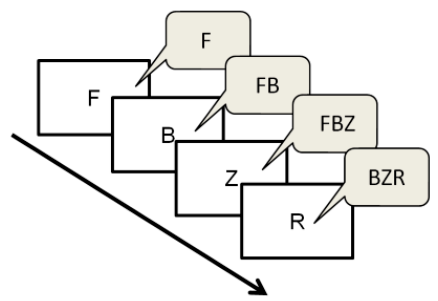
Figure 1. Visual representation of the letter-memory test. Each trial consists of a series of five, seven or nine consonants, one letter at a time, as depicted in the white rectangles. The students’ task is to constantly recall the last three letters shown, as depicted in the text balloons. At the end of the series, the student enters the last three letters he/she could recall.